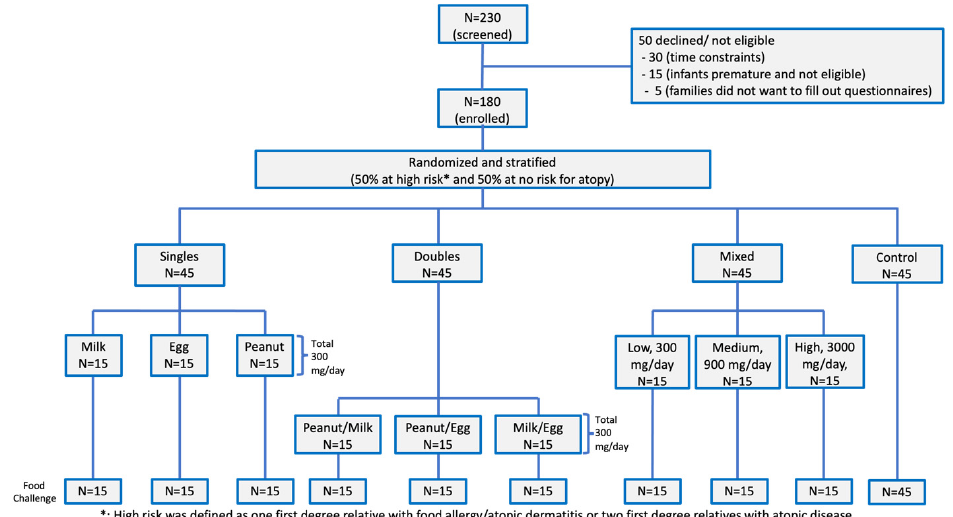
Figure 1. Consort diagram. 180 participants were randomized into three active and one con- trol